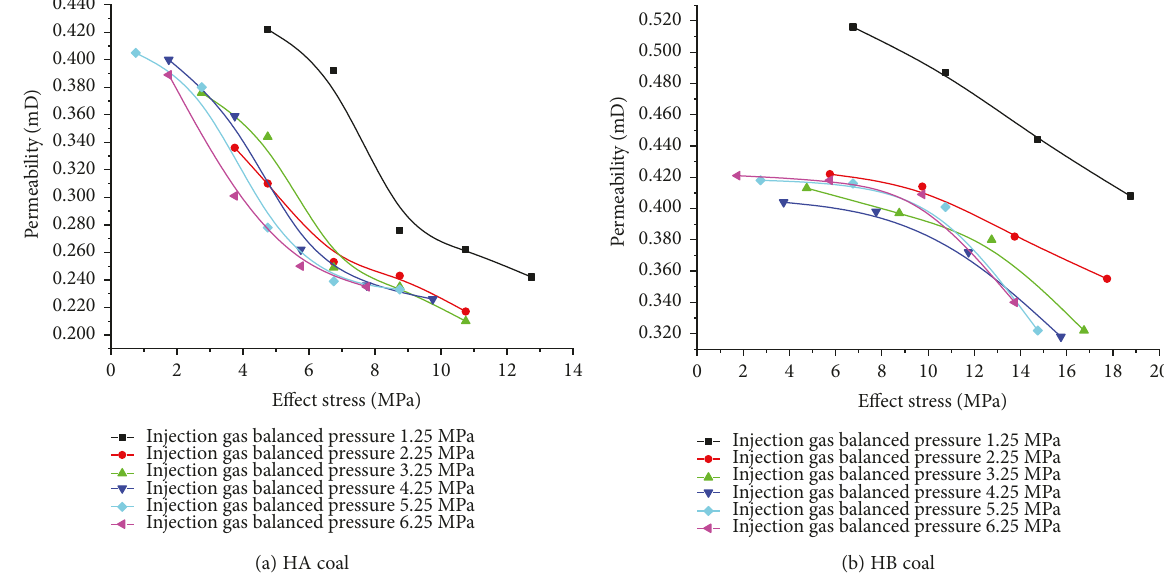
Figure 5: The change of permeability with a variation of e ff ective stress.